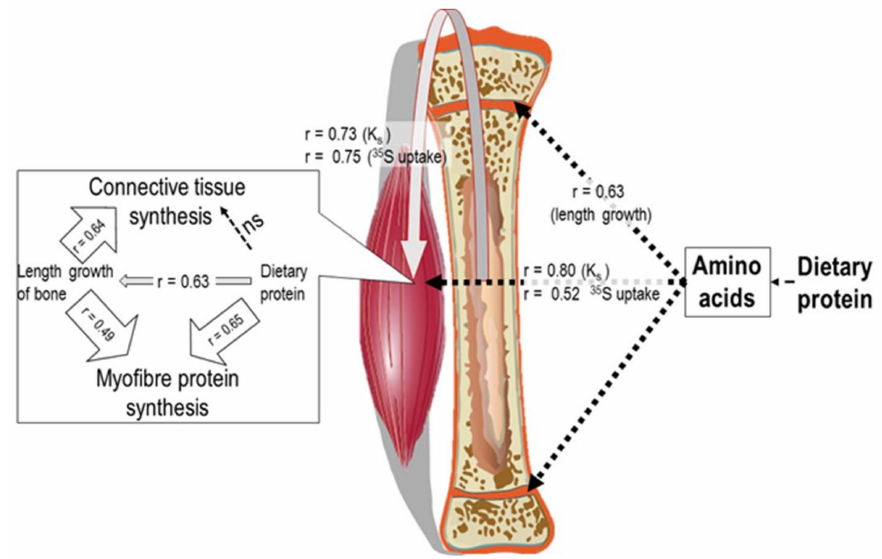
Figure 12. Influences of dietary protein on muscle and bone growth and their interactions [291]. Relationships indicated by full and partial correlation analysis of the interaction between dietary protein intake and bone length growth as determinants of muscle myofibre protein synthesis (Ks) and muscle connective tissue synthesis ( 35 S uptake) in the young rat measured during the first 3 days of variable dietary protein intakes (20%, 7%, 3.5% and 0.5% dietary protein). Bone length growth, muscle Ks and 35 S-uptake were each significantly correlated with dietary protein intake and muscle Ks and 35 S-uptake were each correlated with bone length growth. The independent influences of bone length growth and dietary protein on muscle is indicated by the partial r values in the box on the left, showing that the apparent influence of protein intake on 35 S uptake in muscle is entirely accounted for by its influence on bone length growth, which in turn influences muscle 35 S uptake and myofibre Ks to a lesser extent. Bone length growth was indicated by the more sensitive index of epiphysial cartilage width which is proportional to and an early indicator of, changes in overall tibial length